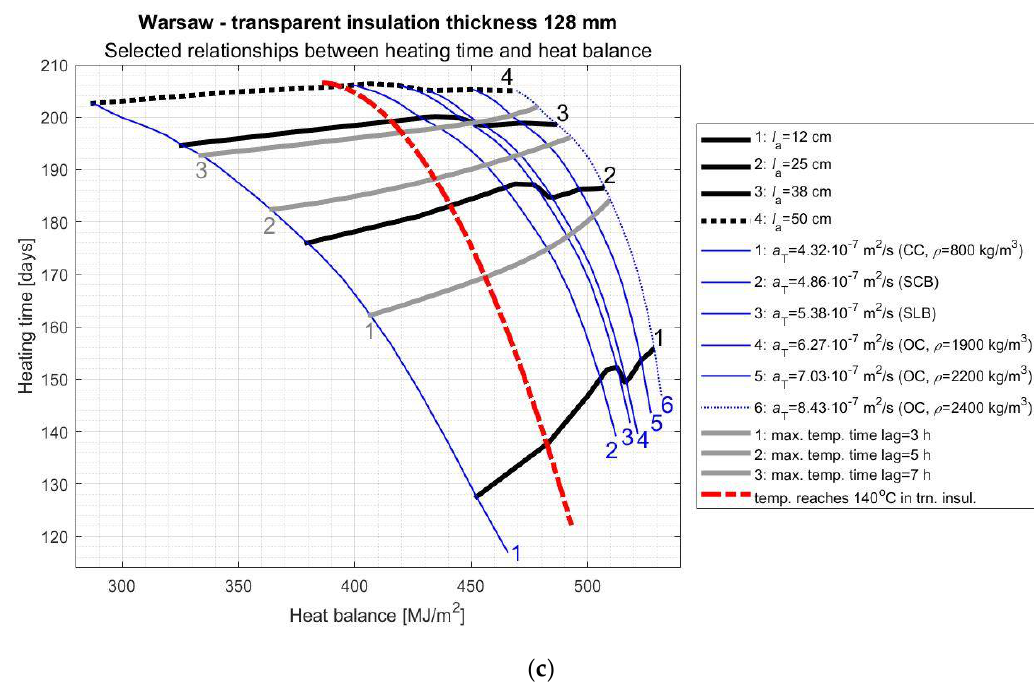
Figure 9. Relationship between the heating time and heat balance for the AL depending on its selected most important features. TI thickness: ( a ) 48 mm, ( b ) 88 mm, ( c ) 128 mm. Location: Warsaw.